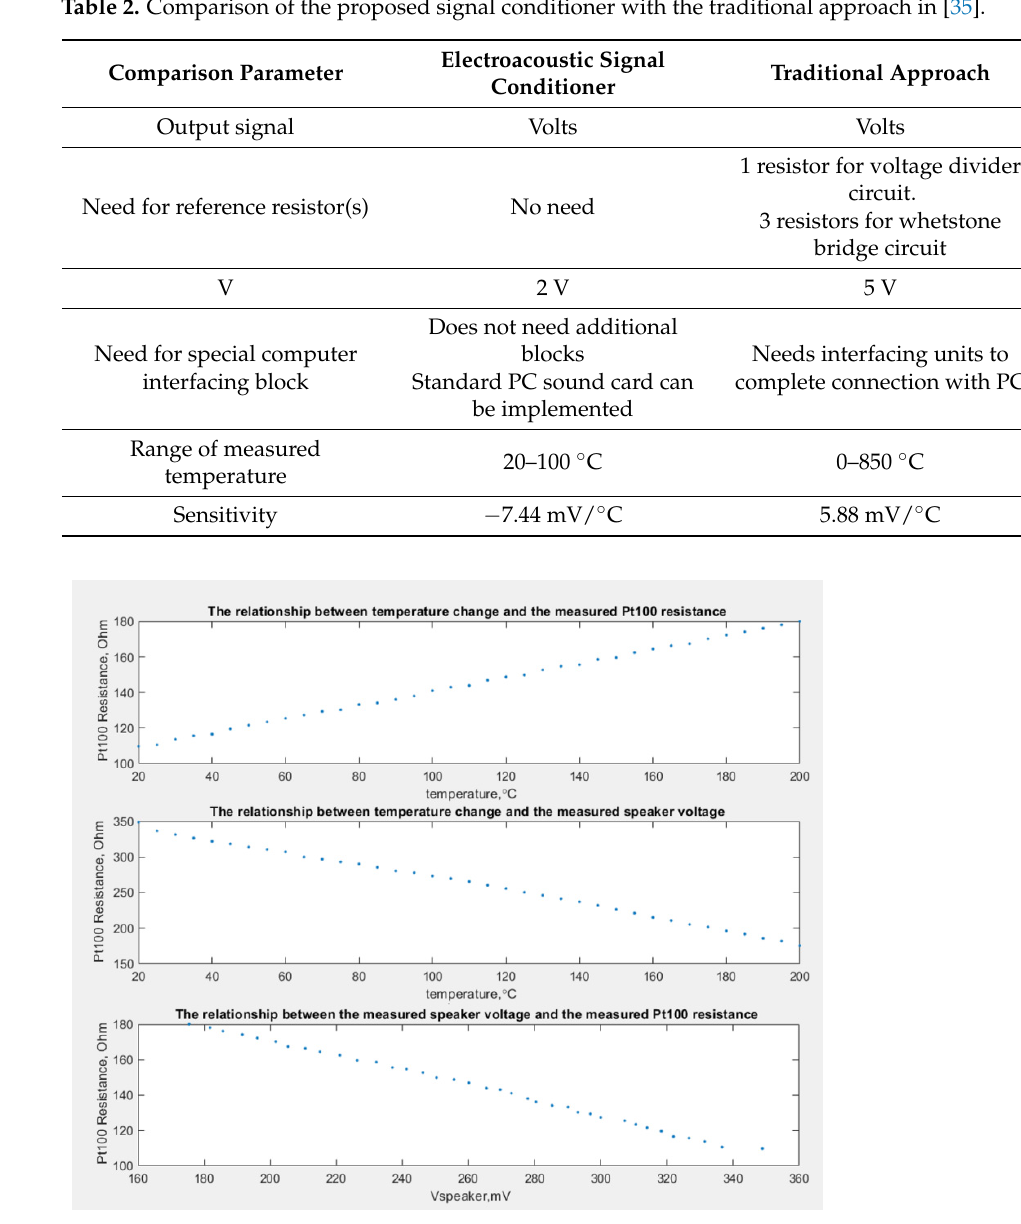
Table 2. Comparison of the proposed signal conditioner with the traditional approach in [35].